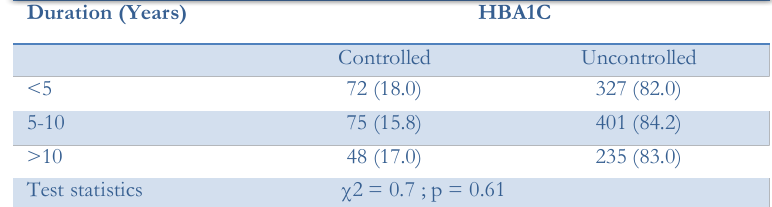
Table 4: Duration of diabetes and status of diabetes control (n=5140)